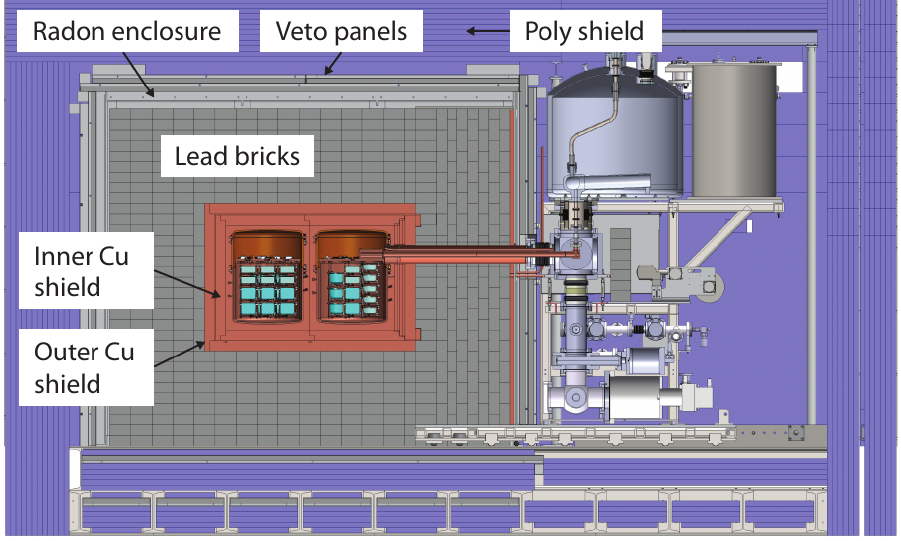
Figure 2. A drawing of the content of Figure 8. Pictorial view of the Majorana experimental setup. Figure published by J. Phys. Conf. Ser., 2020 module 1 (top) and 2 (bottom). Blue detectors Figure 3. A drawing of the 76 Majorana Demonstrator shield, have the natural Ge isotopic abundance, while green are enriched to 88%. with modules inserted.